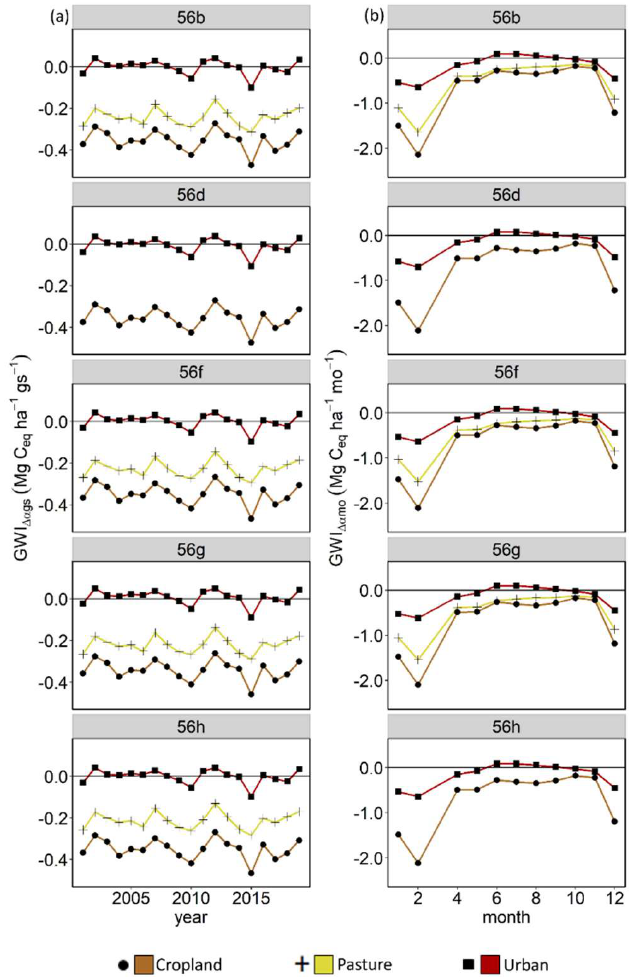
Figure 4. Albedo-induced global warming impact (GWI ∆ α ) for a given cover type within the five Level IV ecoregions. Panels ( a , b ) represent the GWI ∆ α for the growing season (GWI ∆ α gs ; 2001–2019) and monthly (GWI ∆ α mo ; January–December, less March) periods, respectively. Positive and negative values of GWI ∆ α indicate warming and cooling effects, respectively, equivalent to Carbon (C eq ) emission and mitigation, respectively.